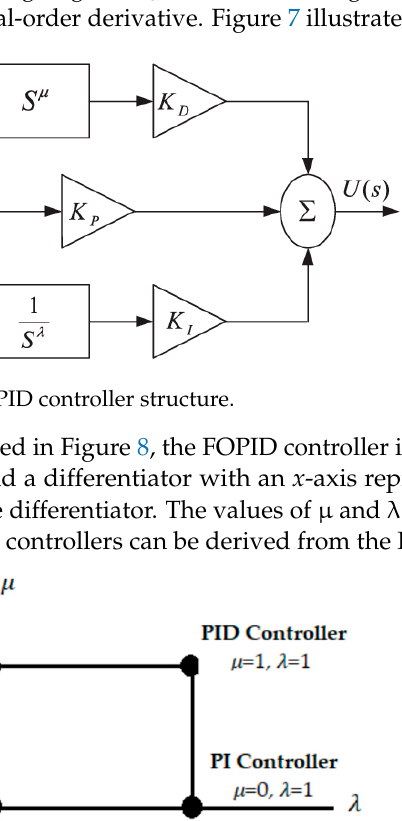
Figure 8. Graphical representation of FOPID controller.